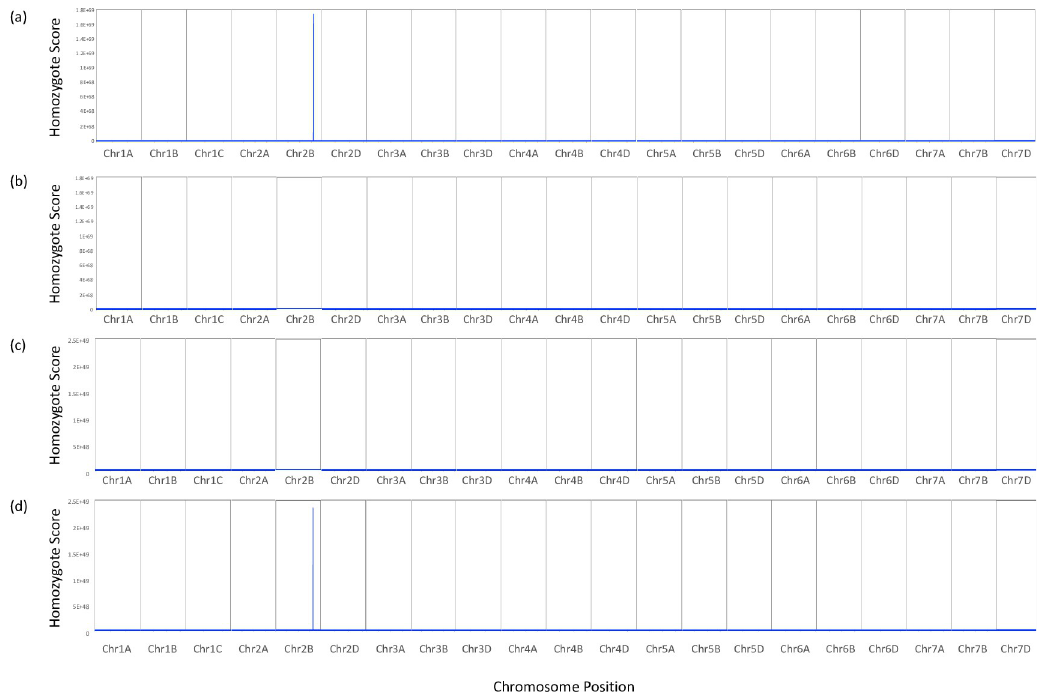
Fig 4. Homozygosity scores calculated for the Yr7 and yr7 bulked datasets along each chromosomal pseudomolecule. Scores calculated per 10,000,000bp window along each chromosome at 10,000bp intervals. (a) Scores plotted for ‘Cadenza unique homozygote alleles’ found in the Yr7 bulk segregated dataset. (b) Scores plotted for ‘Avalon unique homozygote alleles’ found in the Yr7 bulk segregated dataset. (c) Scores plotted for ‘Cadenza unique homozygote alleles’ found in the yr7 bulk segregated dataset. (d) Scores plotted for ‘Avalon unique homozygote alleles’ found in the yr7 bulk segregated dataset.